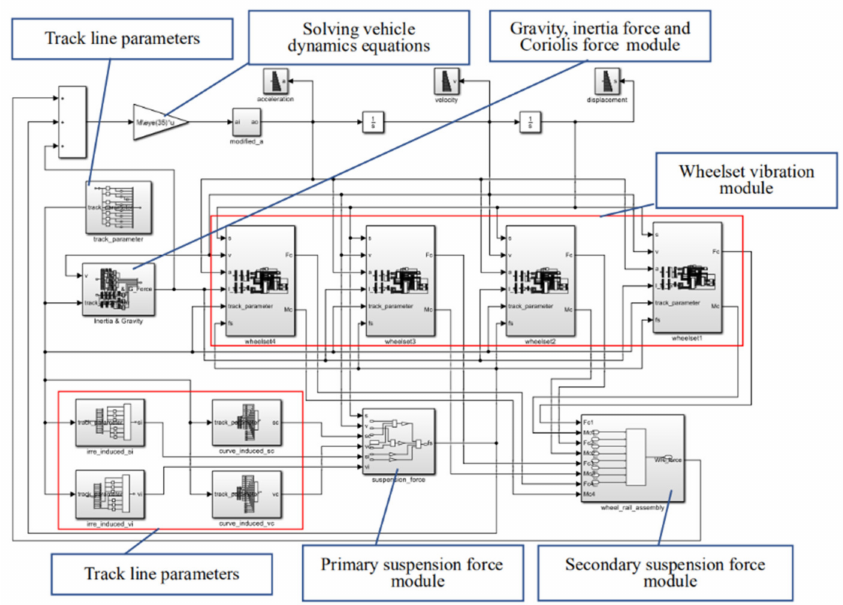
Figure 3. Vehicle dynamics model based on Simulink.